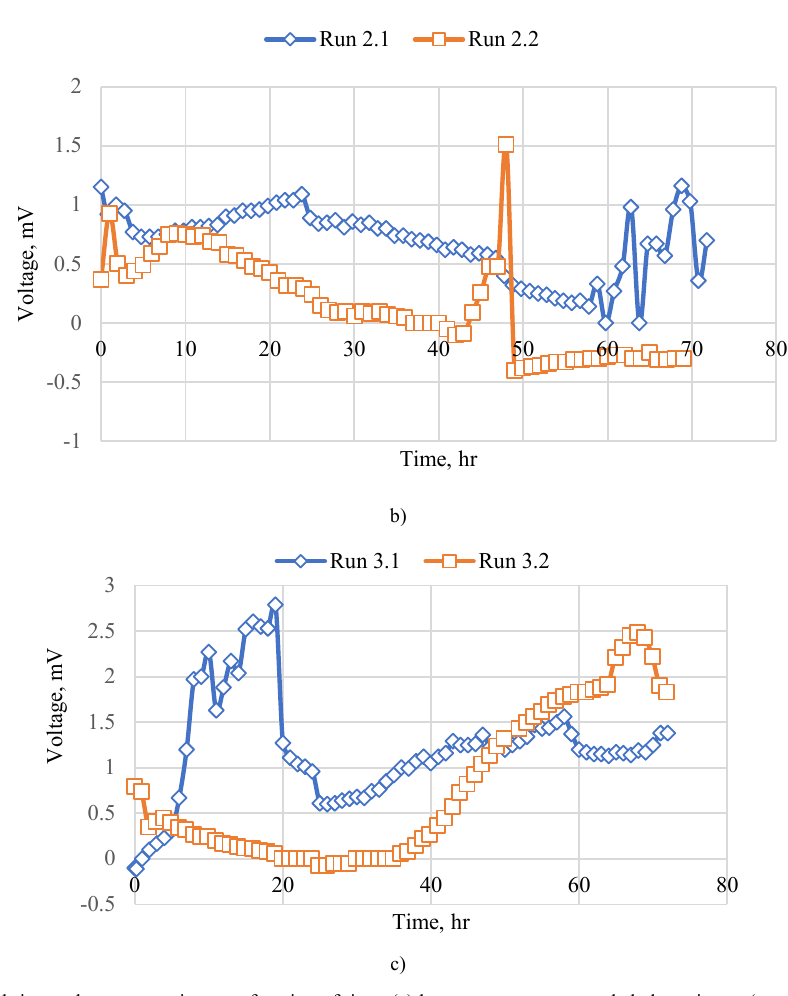
Fig. 2. Real-time voltage generation as a function of time. (a) brewery wastewater and sludge mixture (combination 1); (b) potato wastewater and sludge mixture (combination 2); and (c) potato waste and animal dung mixture (combination 3). For combination 2, potato waste was used as the substrate which had a lower COD. This is reflected in a lower overall voltage among the combinations. Steady-like behaviour can be seen for both runs 2.1 and 2.2 of this combination, straight lines and little fluctuation are visible until the later stages where the voltage decreases and reaches almost zero (see Fig. 2(b)). The trend downwards indicates an exhaustion of nutrients [13]. In Run 2.1, from the 58 th hour there were large ripples, and this can be attributed to the nature of bacteria (see Fig. 2(b)). Bacteria undergo a boom-bust relationship where they start up with exponential growth, reach a static phase and then die out when there are not enough nutrients [16]. The peaks can be seen to depict new bacteria life cycles and different bacteria reacting with different organic nutrients. Combination 3 produced contrasting trends with run 3.1 having a large initial spike while for run 3.2 the voltage increased gradually. This combination produced higher voltage